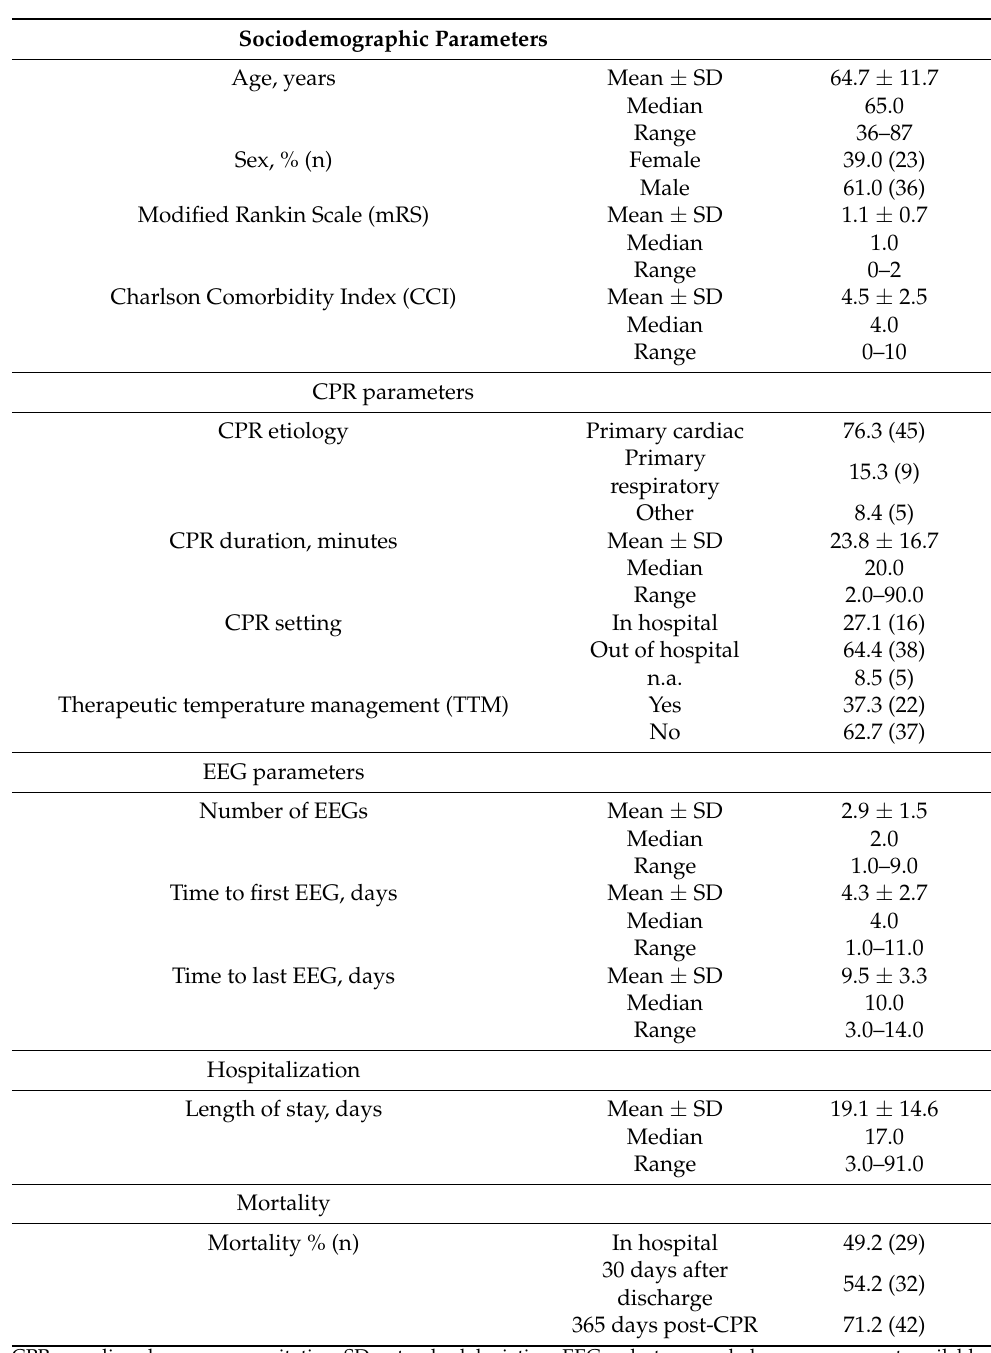
Table 2. Sociodemographic, length of stay, CPR, and outcome parameters for the study population (n =